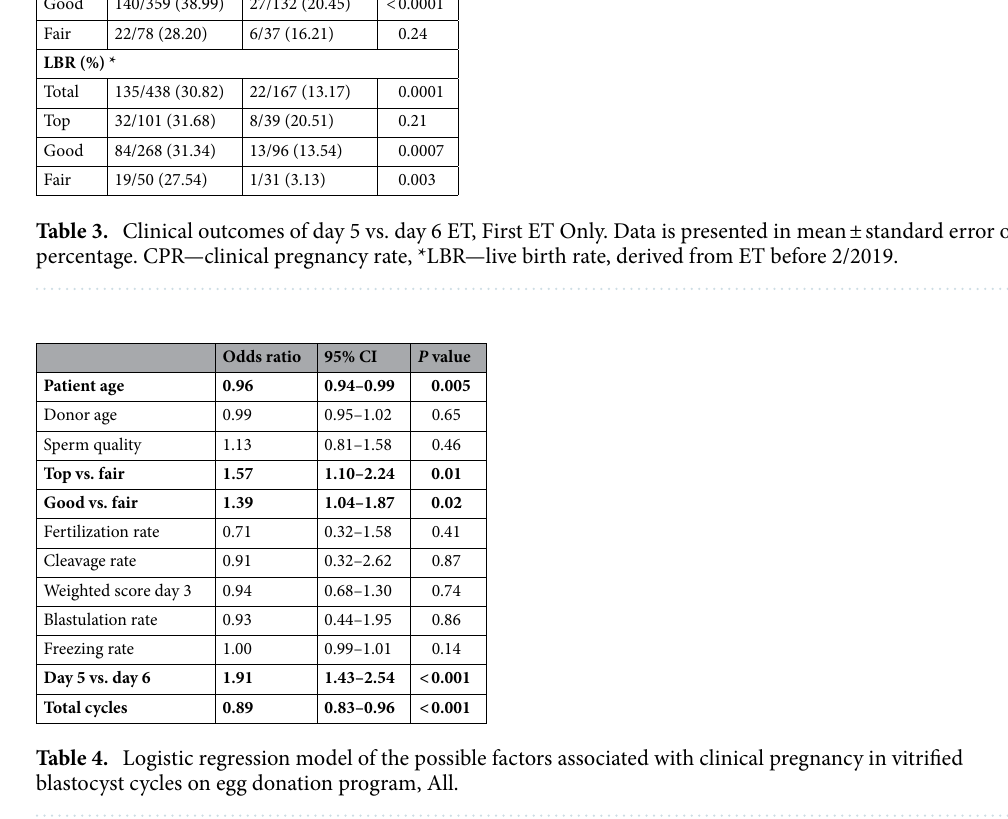
Table 4. Logistic regression model of the possible factors associated with clinical pregnancy in vitrified blastocyst cycles on egg donation program, All.